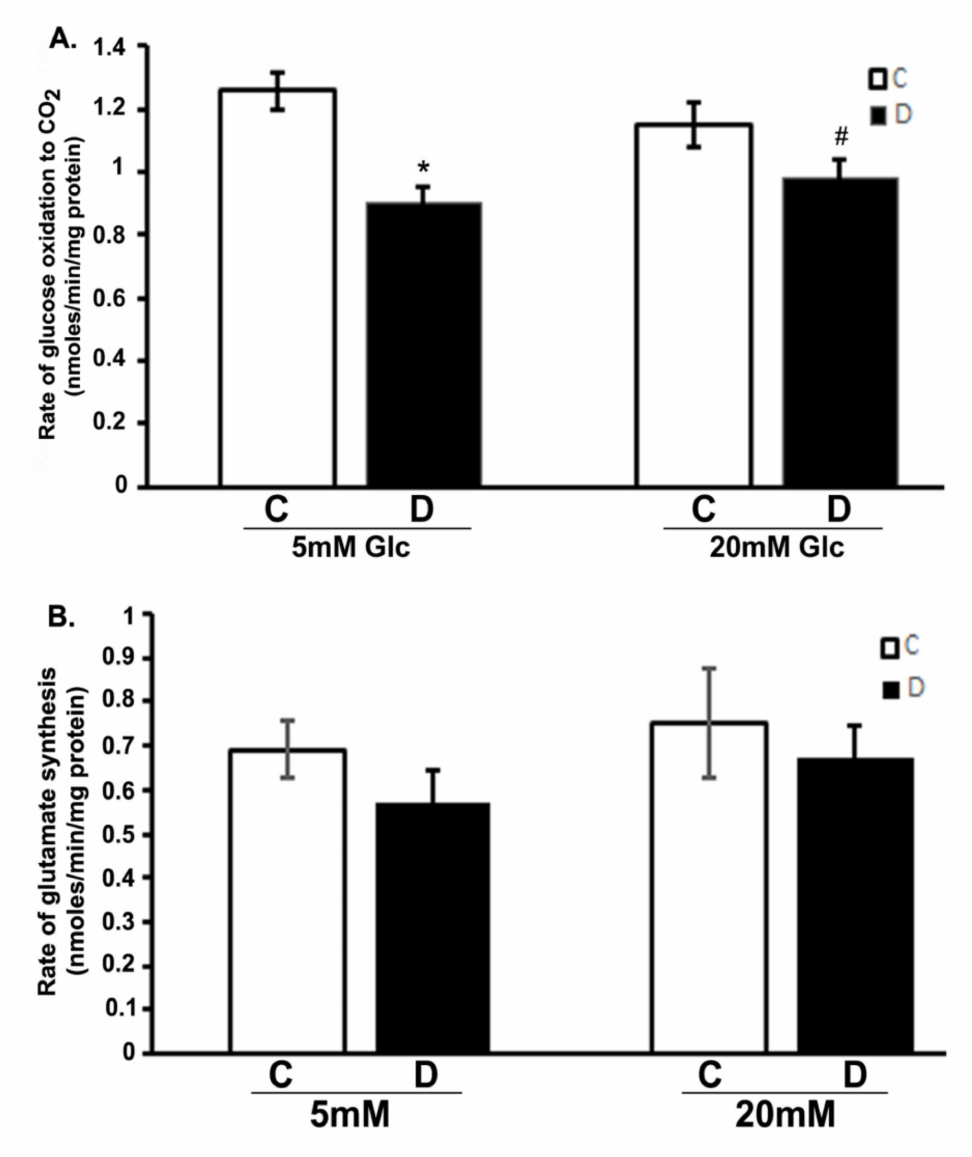
Figure 1. Glucose oxidation in the diabetic rat retinas. Retinas from 10-week diabetic rats and their controls were incubated in the buffer with 5 or 20 mM glucose at 37 ◦ C for 30 min. Rates of the production of 14 CO 2 and 14 C-glutamate in retinas were measured as described in the method section. ( A ). Oxidation of glucose to CO 2 in diabetic retinas significantly decreased compared to control retinas (* p < 0.05, control vs. diabetic at 5mM glucose; and # p < 0.05, control vs. diabetic at 20 mM glucose). ( B ). Rate of glutamate synthesis in diabetic retina moderately decreased compared to controls incubated with 5 or 20 mM glucose. Rates of CO 2 and glutamate were measured as nmoles/min/mg of retinal protein. Data are expressed as means ± SEM (n = 6 for